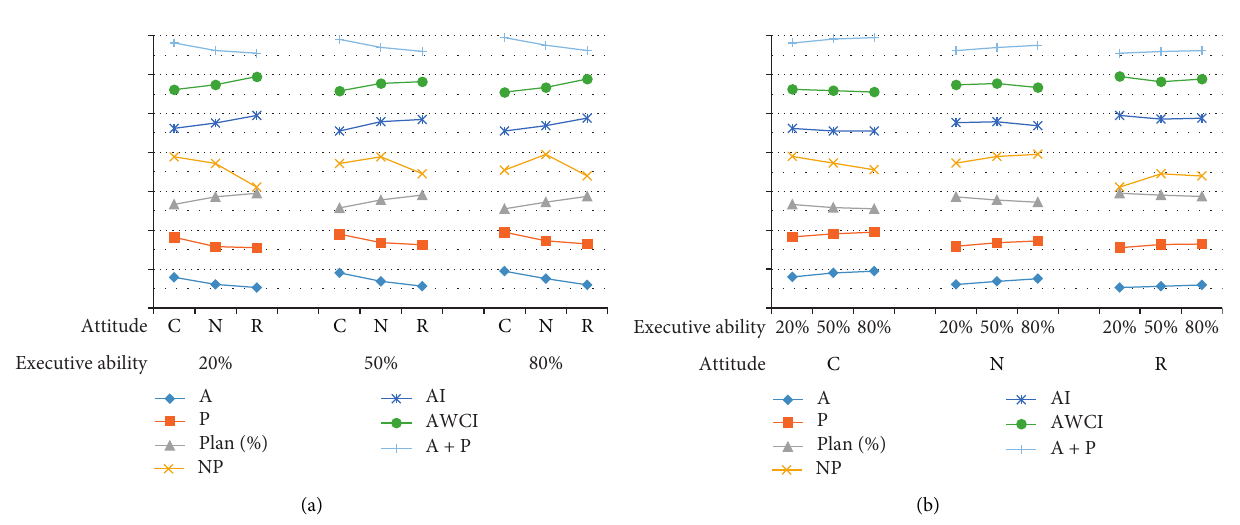
Figure 8: Index comparison between the situations of reasonable planning and unreasonable planning.